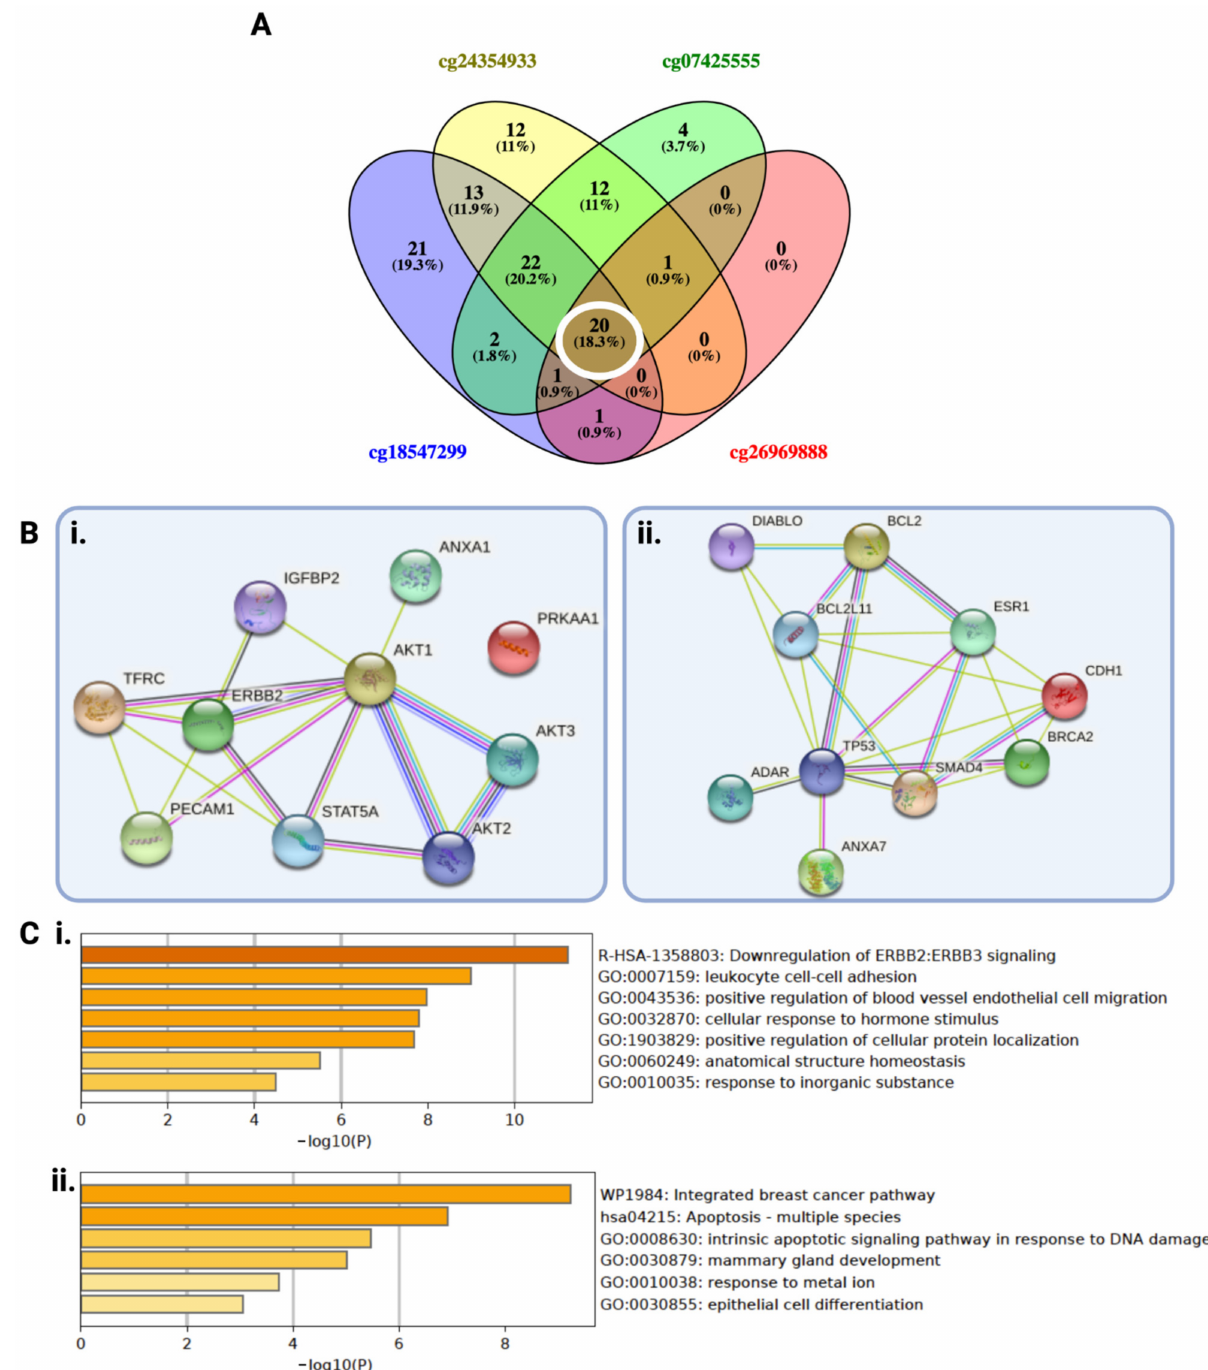
Figure 5. Differential protein expression, protein–protein interaction (PPI), and enrichment analysis. ( A ) Venn diagram presenting the overlap between differentially expressed proteins in four significant PODNL1 CpGs. The white circle represents common differentially expressed proteins between all four CpGs, used for further analysis. ( B ) PPI network visualization of ten proteins upregulated in ( i ). low CpG methylation groups and ( ii ). high CpG methylation groups (STRING). ( C ) Enrichment analysis (MetaScape) of ten upregulated proteins in ( i ). low CpG methylation groups and ( ii ). high CpG methylation groups. Data represents − log 10 p -values. All enriched terms have p -values <